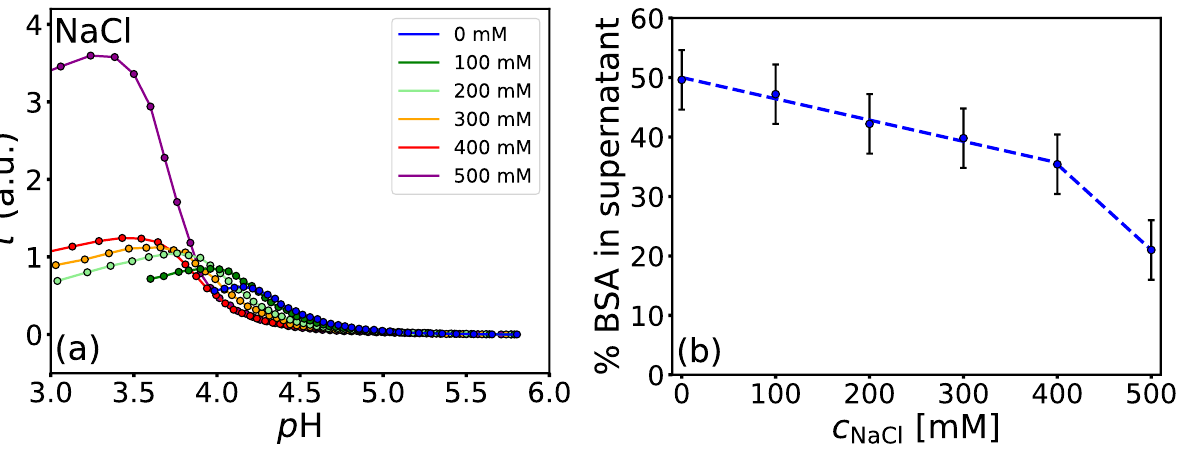
Figure 4. The presence of salts affects protein-PE complexation as well as protein aggregation. ( a ) Turbidi- metric curves for the titration of 100 µ M BSA and 4000 µ M NaPSS in the presence of different NaCl concentrations and ( b ) the concentration of BSA in the supernatant measured after centrifugation of the solutions titrated only to p H opt determined at 25